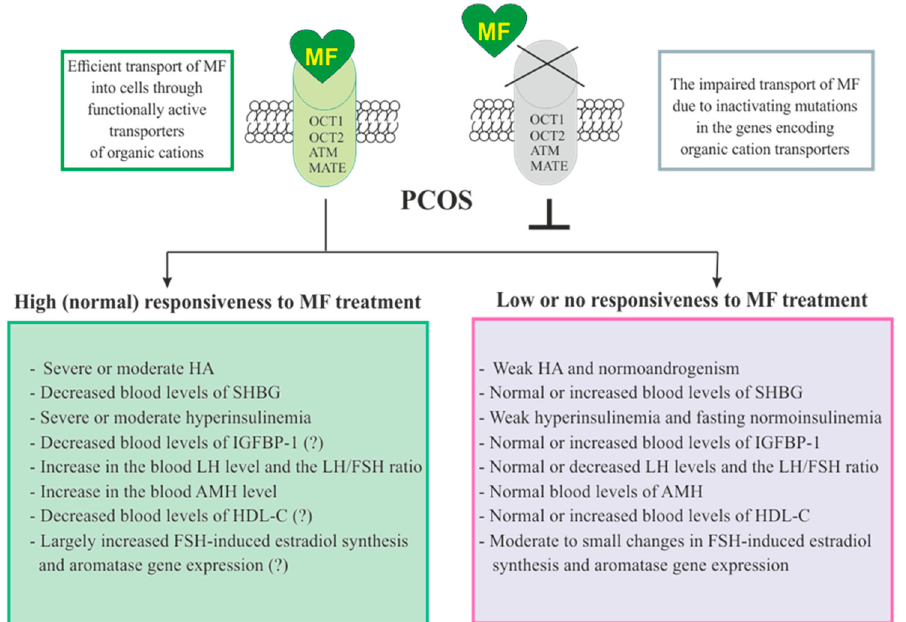
Figure 3. Factors determining responsiveness to metformin and the effectiveness of metformin therapy in women with PCOS. W omen with PCOS, as well as the patients with other pathologies, must have functionally active transporters of organic cations (OCT1, OCT2, and others) in order to respond to MF, since inactivating mutations and polymorphisms in the genes encoding these transporters lead to impairment of MF transport into the cell and make MF therapy ineffective. Since MF improves metabolic parameters and insulin sensitivity, its effectiveness in PCOS women with overweight or obesity, as well as with severe dyslipidemia and impaired glucose tolerance, is usually higher. There is evidence that MF therapy is most effective in PCOS women who have pronounced signs of hyperinsulinemia and hyperandrogenism, the increased LH levels and the LH/FSH ratio, the decreased levels of SHBG, IGFBP ‐ 1 and HDL ‐ C, and the increased levels of AMH. It can also be assumed that MF will be more effective in patients with increased aromatase expression and ovarian hypersensitivity to FSH, since one of the mechanisms of MF action is normalization of the expression of genes encoding the FSH receptor and aromatase, as well as normalization in the response of ovarian cells to stimulation of FSH. Details and bibliographic references are presented in the Section 3.5. Abbreviations: AMH, anti ‐ Müllerian hormone; FSH, follicle ‐ stimulating hormone; HDL ‐ C, high ‐ density lipoprotein cholesterol; IGFBP ‐ 1, insulin ‐ like growth factor ‐ binding protein ‐ 1; LH, luteinizing hormone; OCT1 and OCT2, organic cation transporters ‐ 1 and 2; SHBG, androgen and sex hormone ‐ binding globulin.